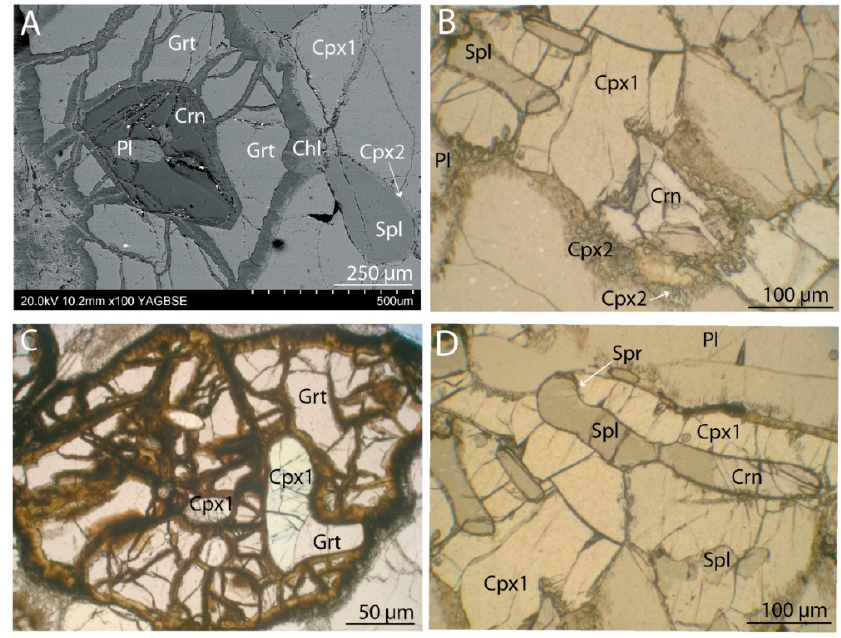
Figure 26. Petrographic aspects of the metagabbroic xenoliths in the Soamiakatra ruby deposit. ( A ) Plagioclase (Pl)-bearing ruby (Crn) within garnet (Grt). Garnet (pyrope) associated with an Al-rich clinopyroxene (Cpx1) and showing a keliphitic texture. The keliphitic halo is composed of small grains of chlorite (Chl). The spinel (Spl) and Cpx1 are bordered by a second generation of clinopyroxene (Cpx2); ( B ) association ruby-Cpx1-plagioclase (Pl)-spinel. The ruby formed upon Cpx1 while small crystals of Cpx2 formed later; ( C ) inclusions of Cpx1 in pyrope (Grt); and ( D ) association spinel-ruby with Cpx1 with plagioclase. Spinel is bordered by sapphirine (Spr). Photos: Saholy Rakotosamizanany.